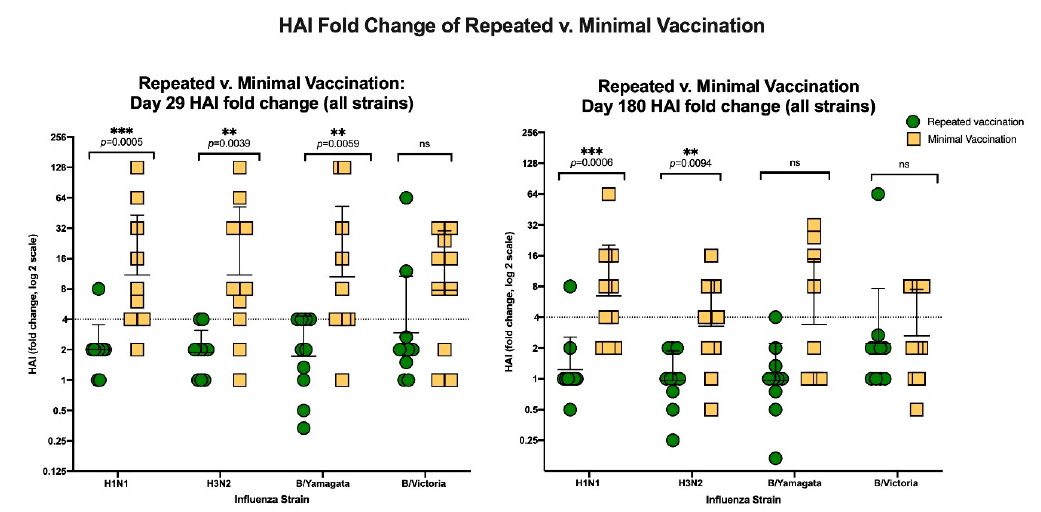
Figure 4. The left panel shows the HAI fold-change from baseline to Day 29 post-vaccination, and the right panel shows the HAI fold-change from baseline to Day 180 post-vaccination. The green dots represent the group that received repeated prior vaccination, and the yellow squares represent the group with minimal prior seasonal vaccination. The horizontal dotted line at 4 represents the fold change magnitude associated with seroconversion. The error bars denote geometric mean and geometric mean standard deviation. The asterisk (**) denotes a significant difference with p < 0.01, (***) denotes a significant difference with p < 0.001, and “ns” denotes a non-significant difference.